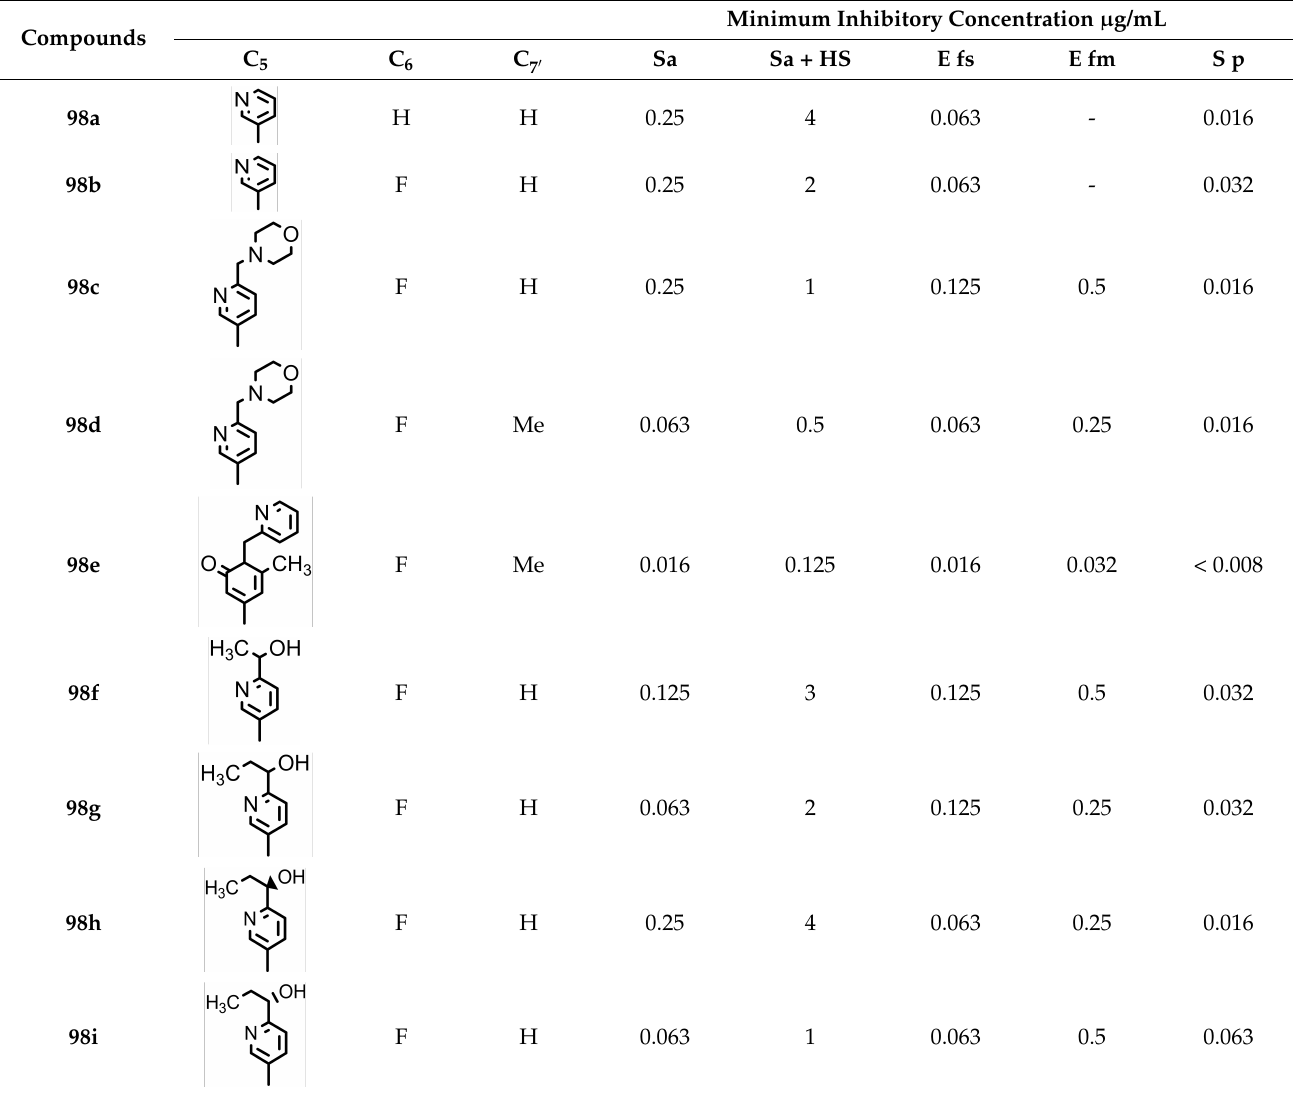
Table 11. MIC values and SAR studies in pyrazole series 17a – 17i